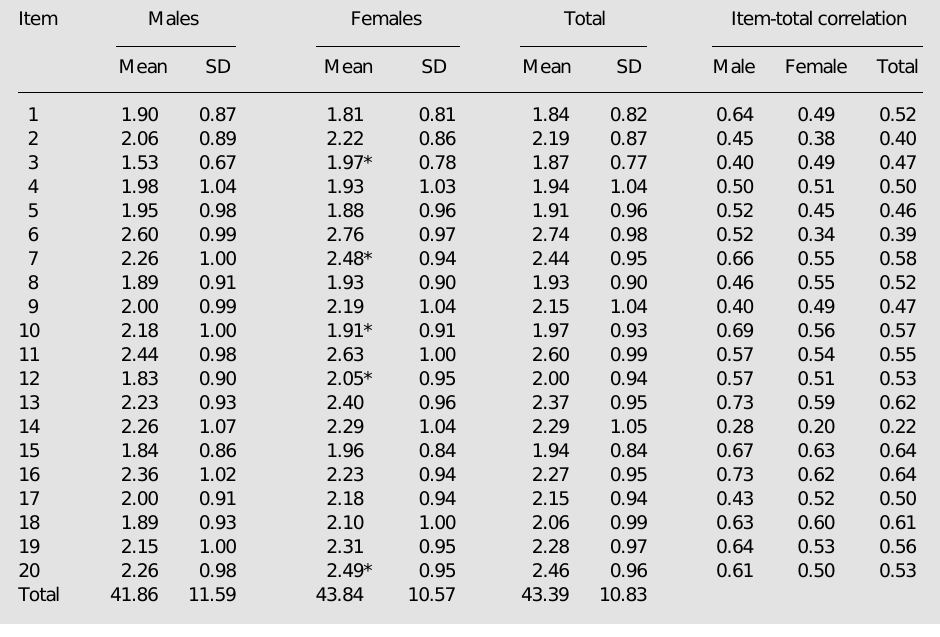
Table 2 - State-Trait Anxiety Inventory (trait form) mean scores and standard deviations (SD) for individual items and item-total correlations for total sample and by gender. Means and SD were calculated considering only inventories without missing values. *P<0.05 significantly different from men’s mean (Student t -test considering Bonferroni adjustment).